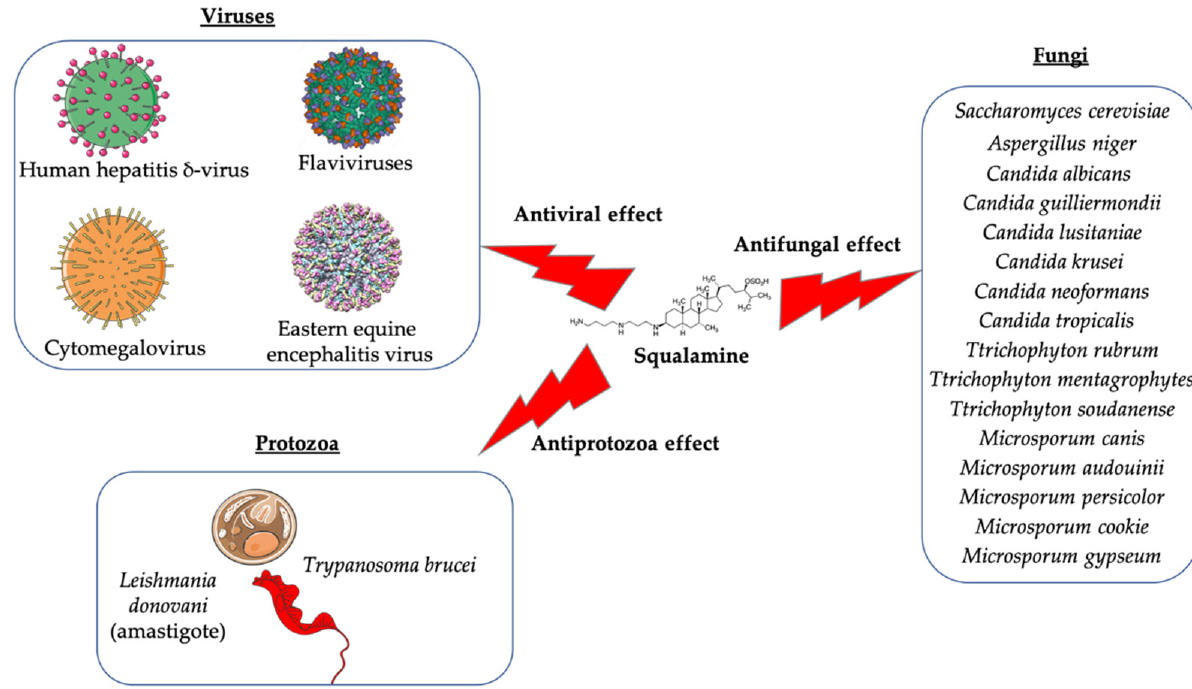
Figure 2. Target pathogens of squalamine: effects on viruses, fungi, and